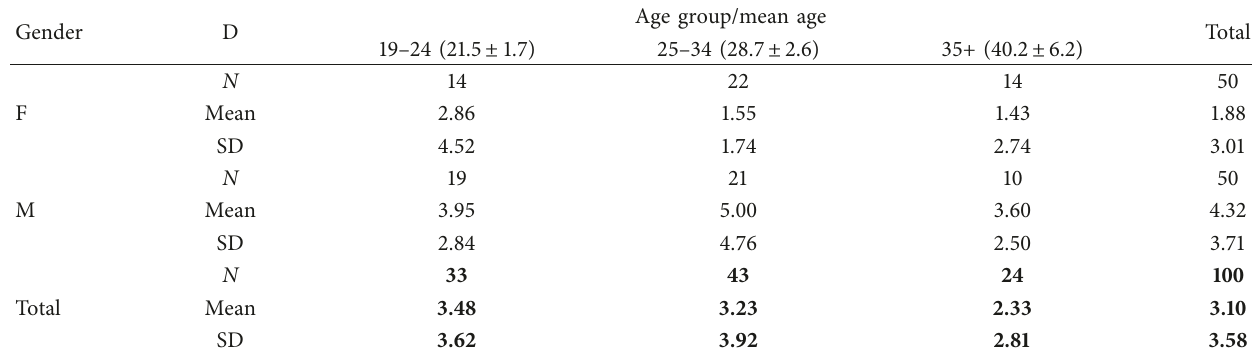
Table 3: Decay (D) value of the adult inmates according to the age group and